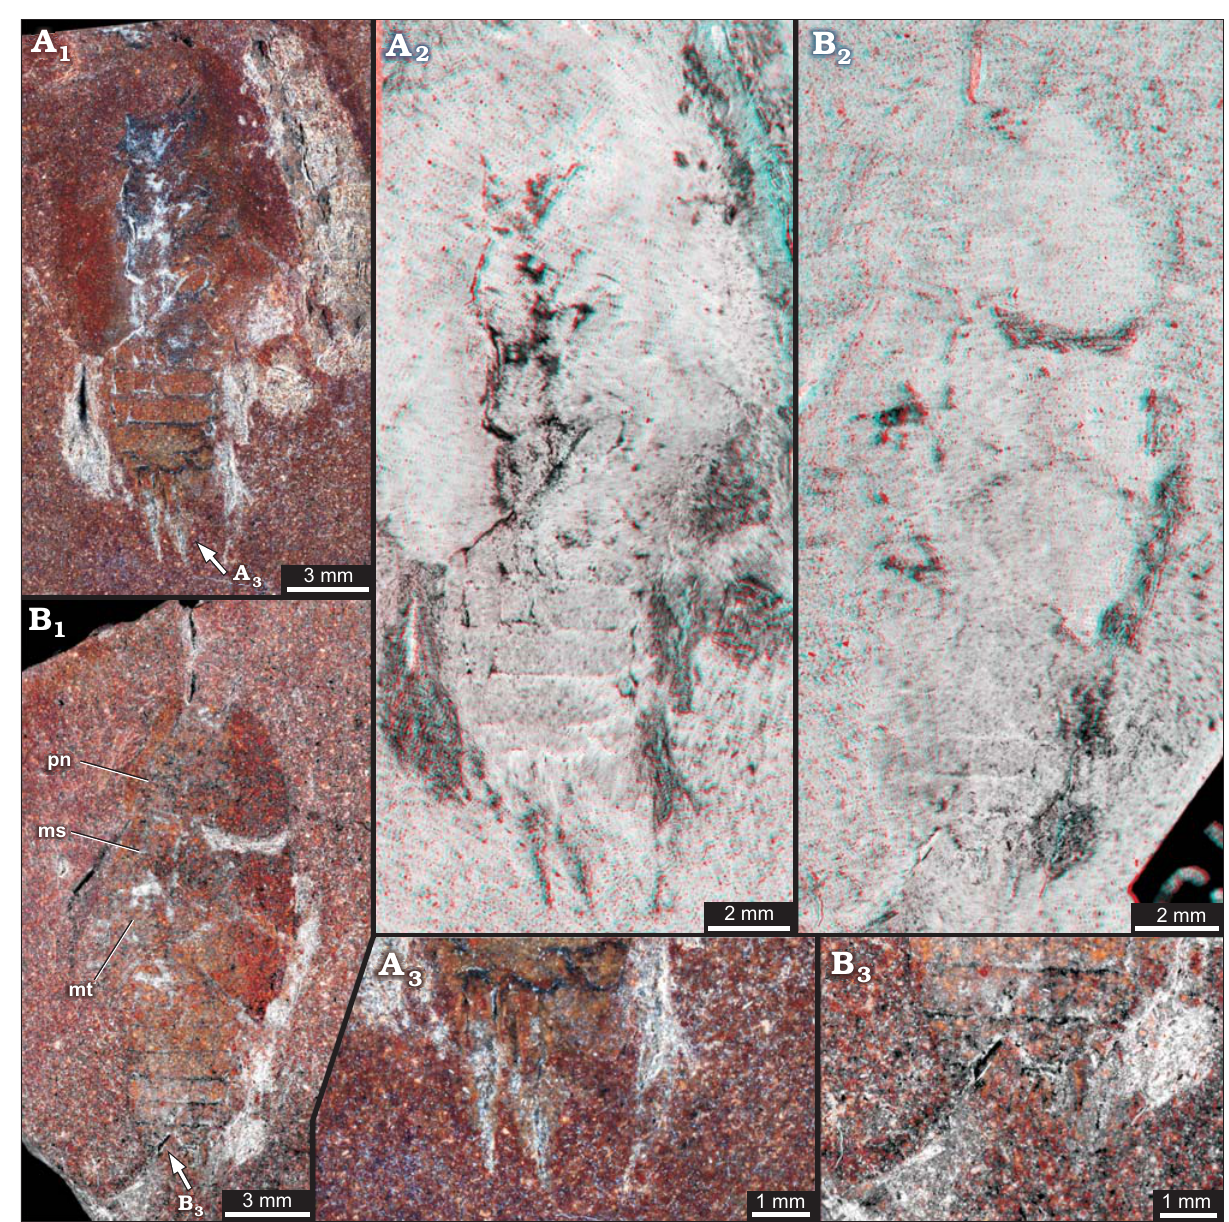
Fig. 4. Roachoid nymph YPM IP 027872 from the Carboniferous Carbondale Formation of Mazon Creek, USA; in dorso-lateral view. Part ( A ) and counterpart ( B ). A 1 , B 1 , overview images; A 2 , B 2 , red-cyan stereo-anaglyphs (please use red-cyan glasses to view); A 3 , B 3 , close up images of ovipositor. Abbreviations: ms, tergite of mesothorax; mt, tergite of metathorax; pn, tergite of